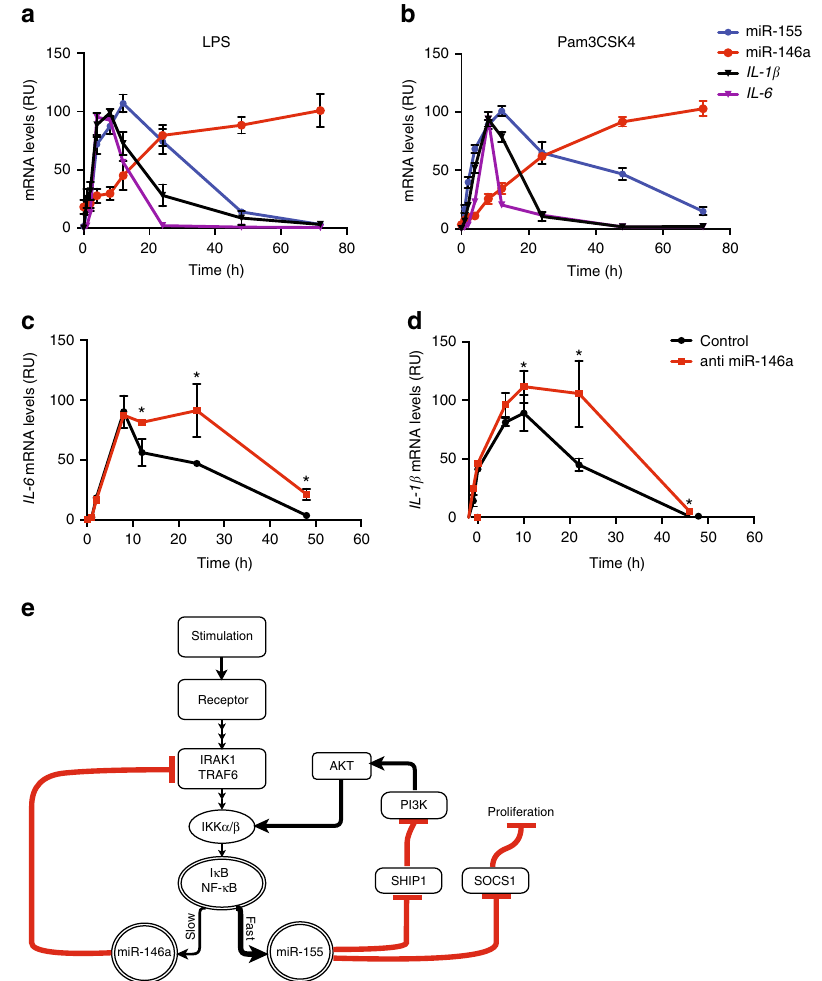
Fig. 7 MiR-155 and miR-146a form a combined positive and negative auto regulatory loop to control precise NF- κ B activity during in fl ammatory stimuli. The dynamic expression of miR-155, miR-146a, and the NF- κ B targets IL-1 β and IL-6 at different time points after LPS ( a ) and Pam3CSK4 ( b ) stimulation. The dynamic expression of IL-6 ( c ) and IL-1 β ( d ) mRNA in WT BMMs transfected with miR-146a speci fi c anti miR (red) or control (black) 2 h post LPS stimulation (100 ng/mL). e A suggested model for the miR-146a and miR-155 regulatory loop during in fl ammatory stimulation. a , b N = 4 per group from two independent experiments. * p < 0.05, using one-way ANOVA ( c , d 146a and miR-155 with NF- κ B activity during TLR activation